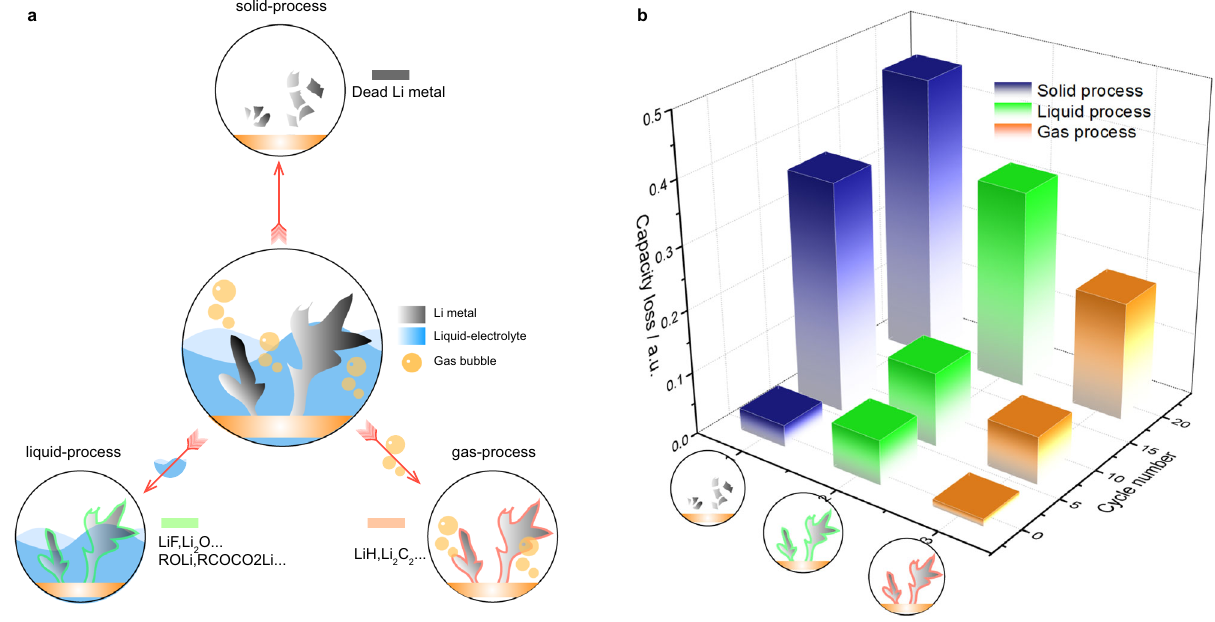
Fig. 5 | Proposed three formation-process of inactive Li and their corre- sponding amount that determined by mass spectrometry titration method. a Theschematicofinactive Liformationthrough(i)Solid-process:formingdeadLi metal;(ii) Liquid-process: forming inactive Li throughthe reactions between liquid electrolytewithLimetal;(iii)Gas-process:forminginactiveLithroughthereactions